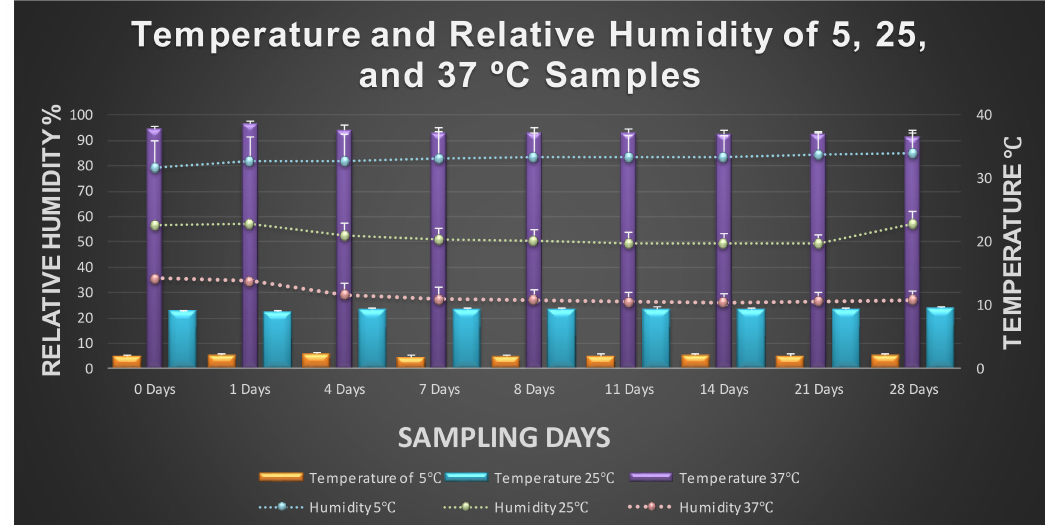
Figure 1. Average hourly temperature and relative humidity of 5, 25, and 37 ◦ C samples during the sampling period from 0 to 28 days. Bar graphs represent temperature and line graphs represent relative